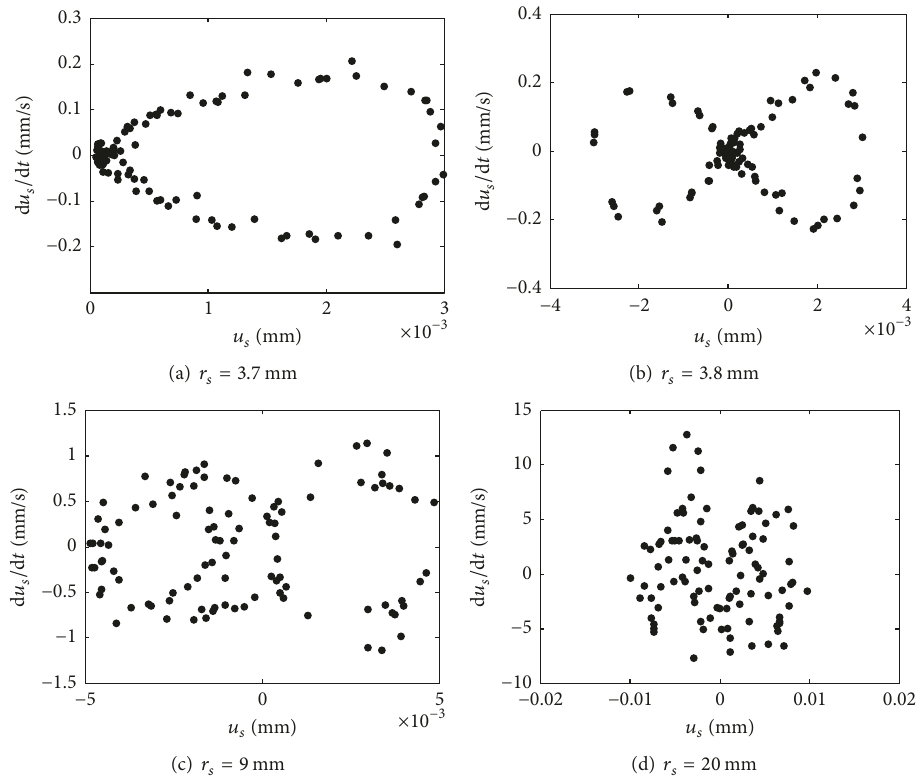
Figure 9: Poincare map of vibration response of wave generator for different theoretical